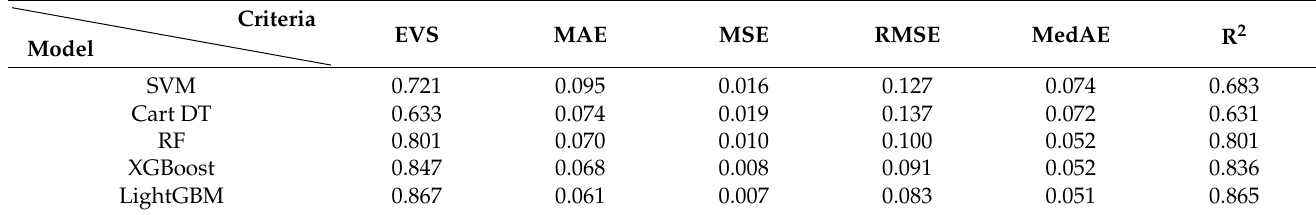
Table 5. Test set evaluation results of different machine learning models.